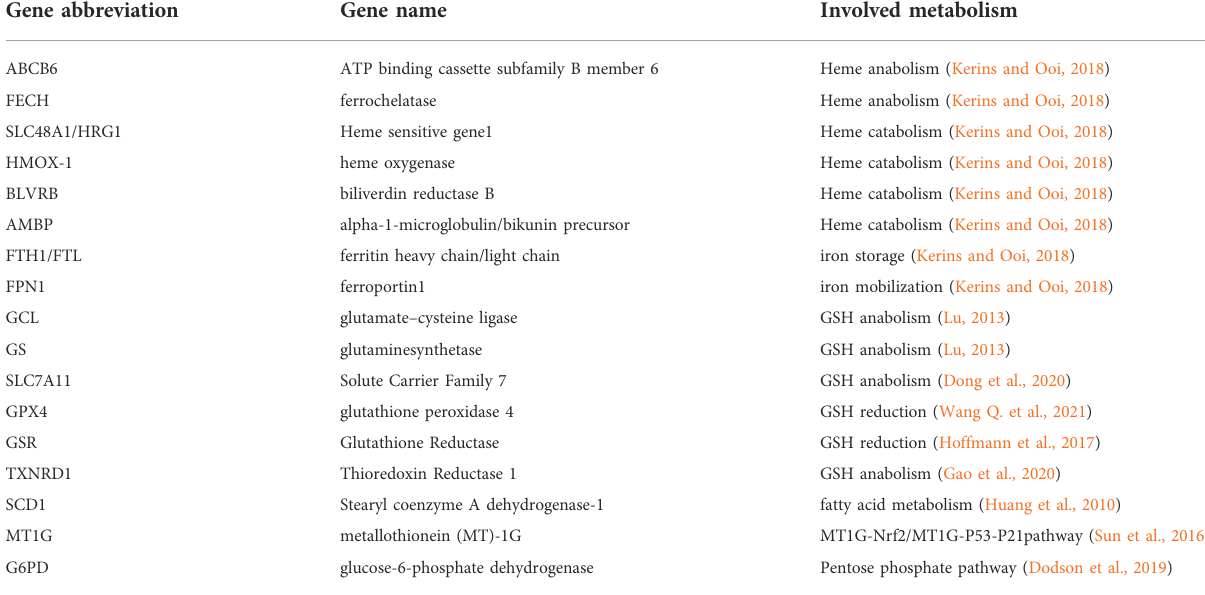
TABLE 4 Nrf2-regulated iron and glutathione metabolism related